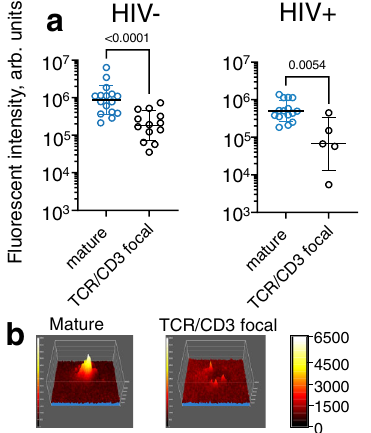
Fig. 7 | Intensity and quality of degranulation depends on stage of T cell dif- ferentiationandtypeofsynapticinterface. Naive,TMandEMCD8Tcellsubsets were isolated by fl ow cytometry and placed on bilayers containing anti-CD3 anti- bodies and ICAM-1 in the presence of anti-CD107a Fab fragments. Granule release location and anti-CD3 accumulation were observed by TIRF microscopy, ICAM-1 accumulation was imaged with wide- fi eld microscopy. CD107a accumulation measured at 30min of initial T cell contact with bilayer surface. a CD107a levels measured at mature synapses (blue empty circles) and TCR/CD3 focal synapses (black empty circles) formed by naive CD8 T cells. Infection status of donors indicated at the top of the plot. Each dot represents individual cell; mature: n =16 (HIV − )and n =15(HIV+),focal: n =13(HIV − )and n =5(HIV+).Geometricmeanswith geometrical standard deviation factors shown by black lines. Nonparametric